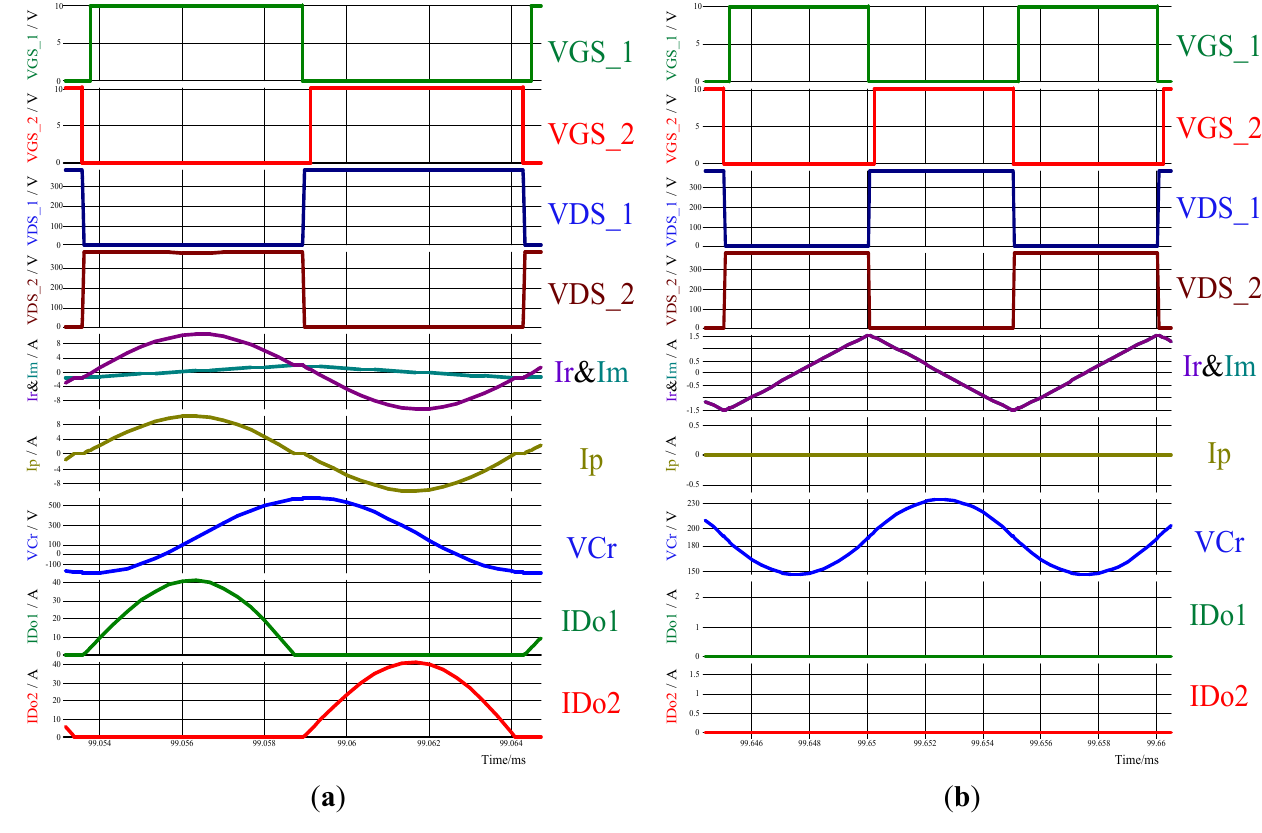
Figure 11. Simulation waveforms for a typical LLC circuit at 1200 W/48 V: ( a ) 100% load; and ( b ) 0%